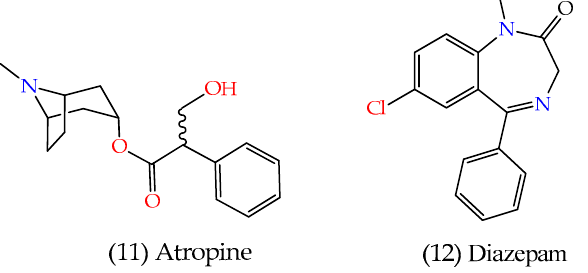
Figure 8. Representation of the chemical structures of atropine and diazepam.